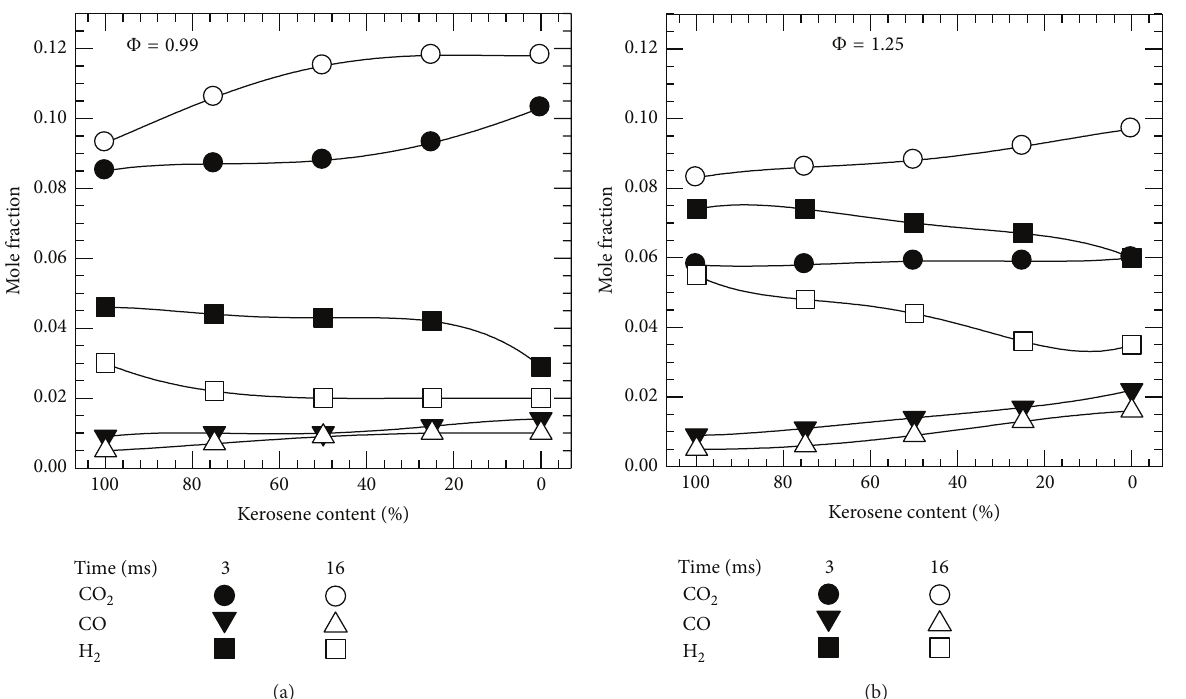
Figure 4: Effect of kerosene content on concentrations for turbulent premixed kerosene light diesel blends-air flame for different equivalence ratios and residence time with Re = 11.08 × 10 3 00 and solidity ratio = 0.68.